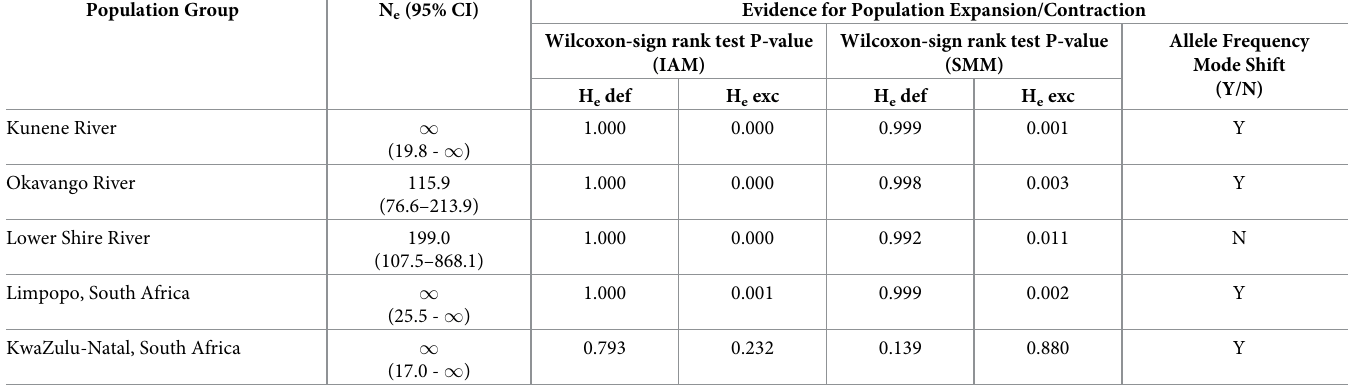
Table 3. Estimates of contemporary N e of four geographic population clusters of Nile crocodiles based on the linkage disequilibrium (LD) method; and the hetero- zygosity excess (H e ) test as an indication of population expansion and contraction based on heterozygosity excess/deficiency under the infinite alleles (IAM) and stepwise mutation (SMM) models (Wilcoxon-sign rank test, P -value), and allele frequency distribution mode shifts. Population